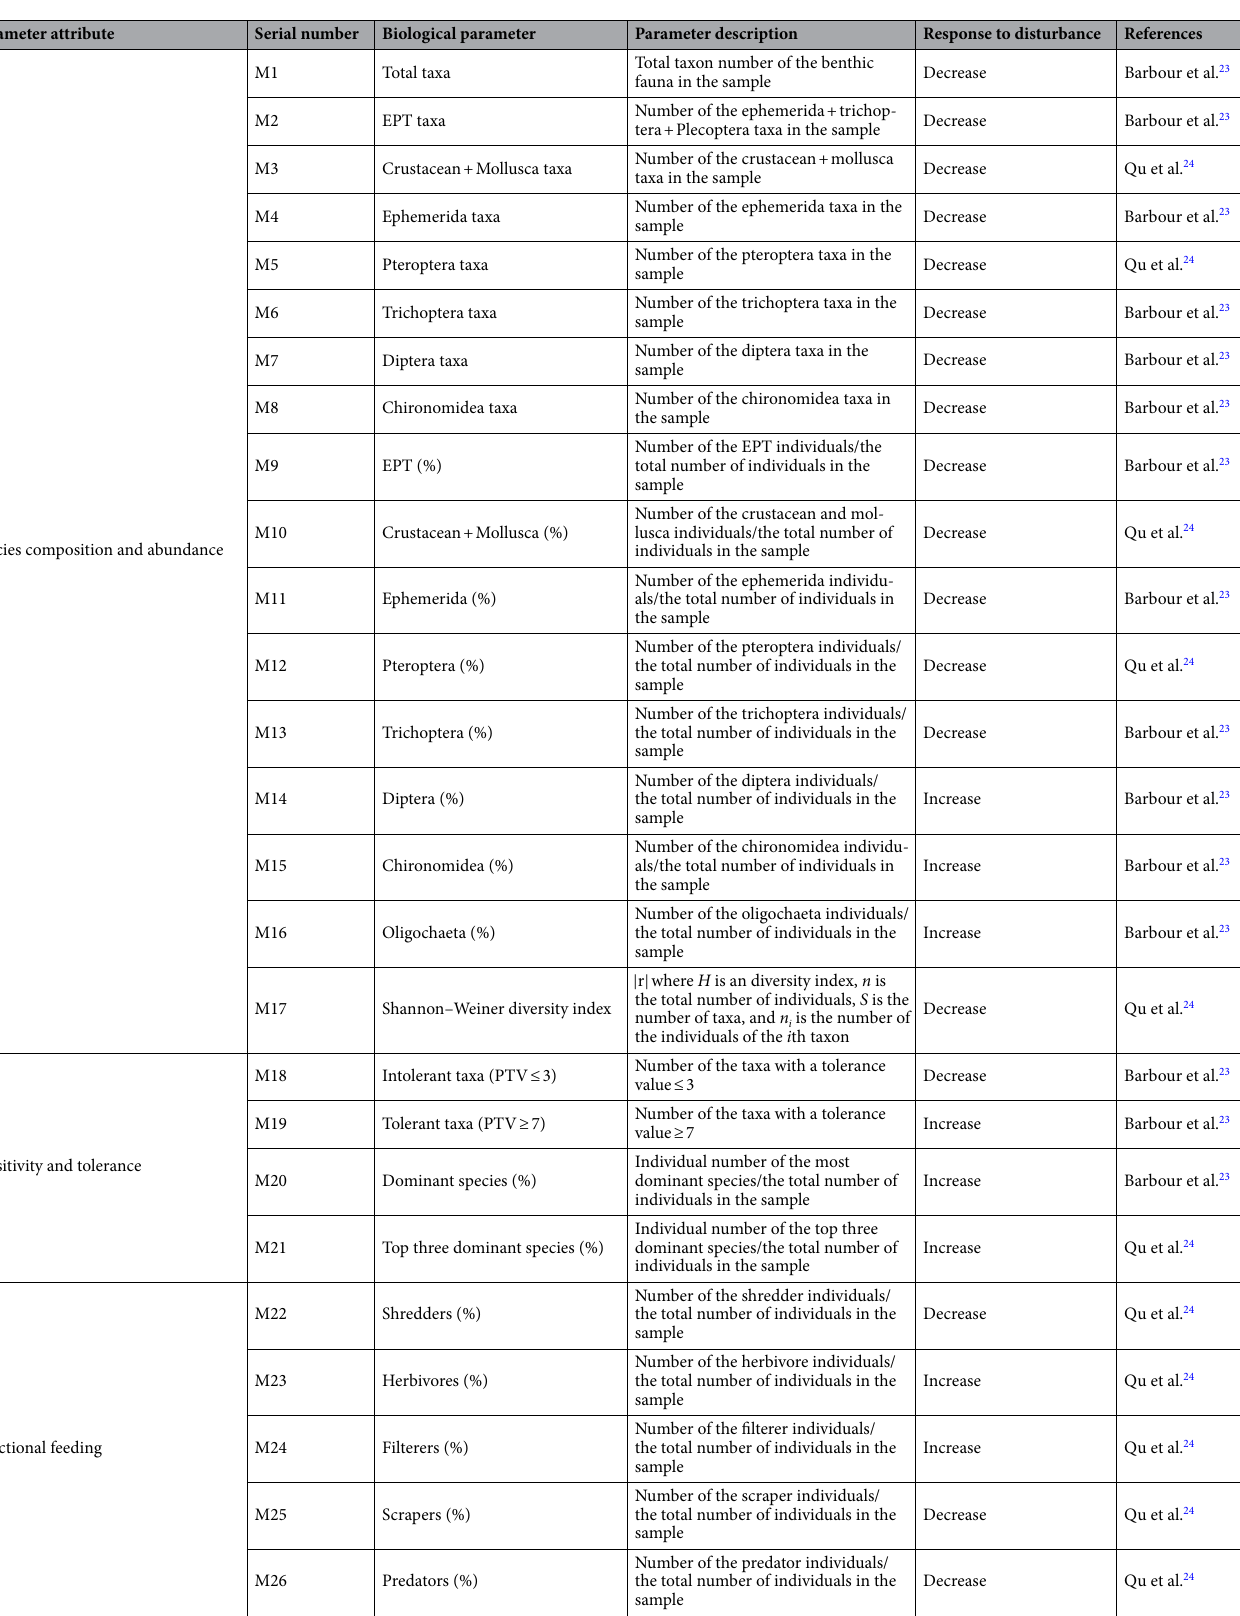
Table 8. Candidate parameters for B-IBI and their response to anthropogenic